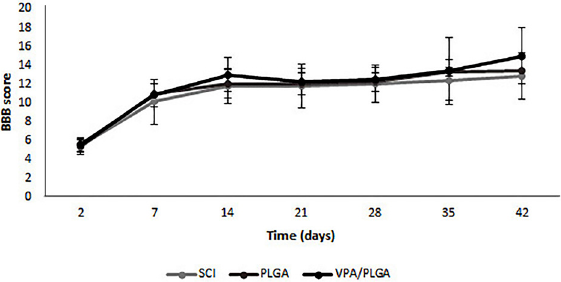
Figure 6. Basso, Beatie and Bresnahan (BBB) open- fi eld walking scores for the spinal cord injury (SCI, control), poly(lactic-co- glycolic acid) (PLGA), and valproic acid (VPA)/PLGA groups on the ipsilateral, lesioned side (n=6 animals/group). Data are reported as means ±